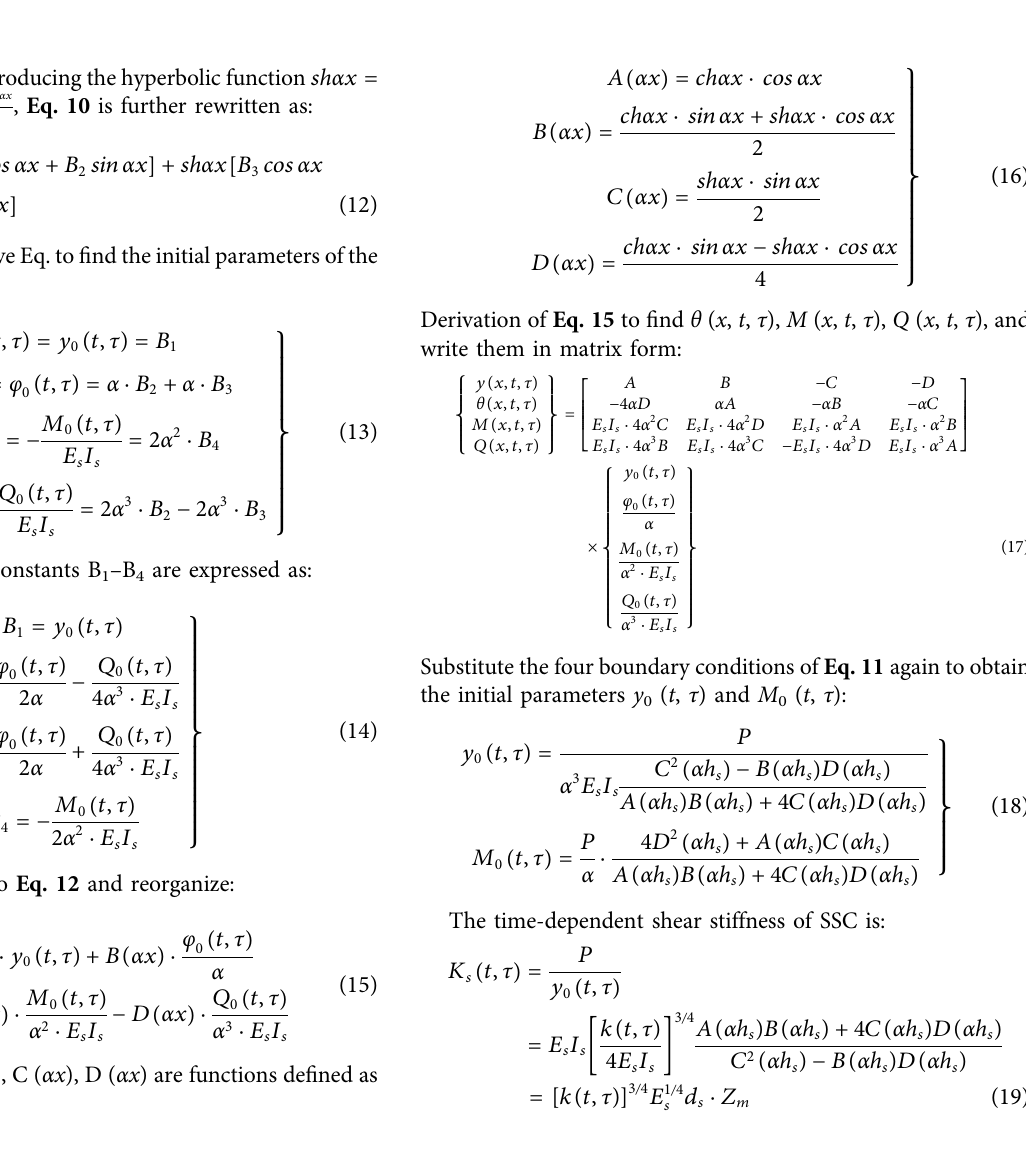
FIGURE 4 | Time-dependent slip predicted by analytical and FE